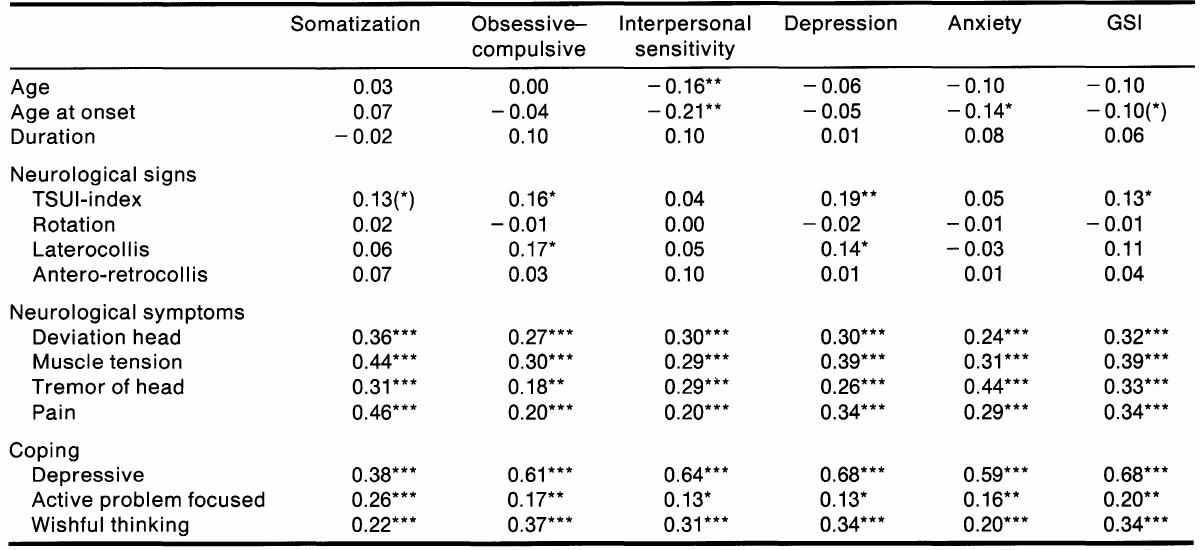
TABLE I. Correlations between psychopathology (SCL 90 R), signs (neurological assessment), symptoms (self reported) and coping (Freiburger Questionnaire for Coping;